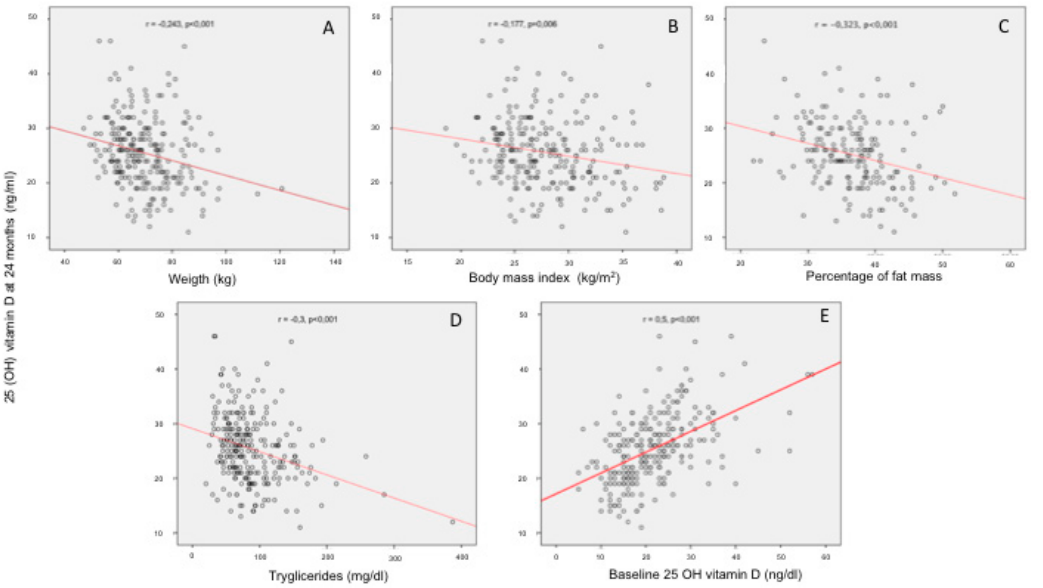
Figure 1. Correlations between serum 25(OH)D levels at 24 months and weight ( A ), body mass index ( B ), percentage of fat mass ( C ), triglycerides ( D ) and baseline 25(OH)D levels ( E ).